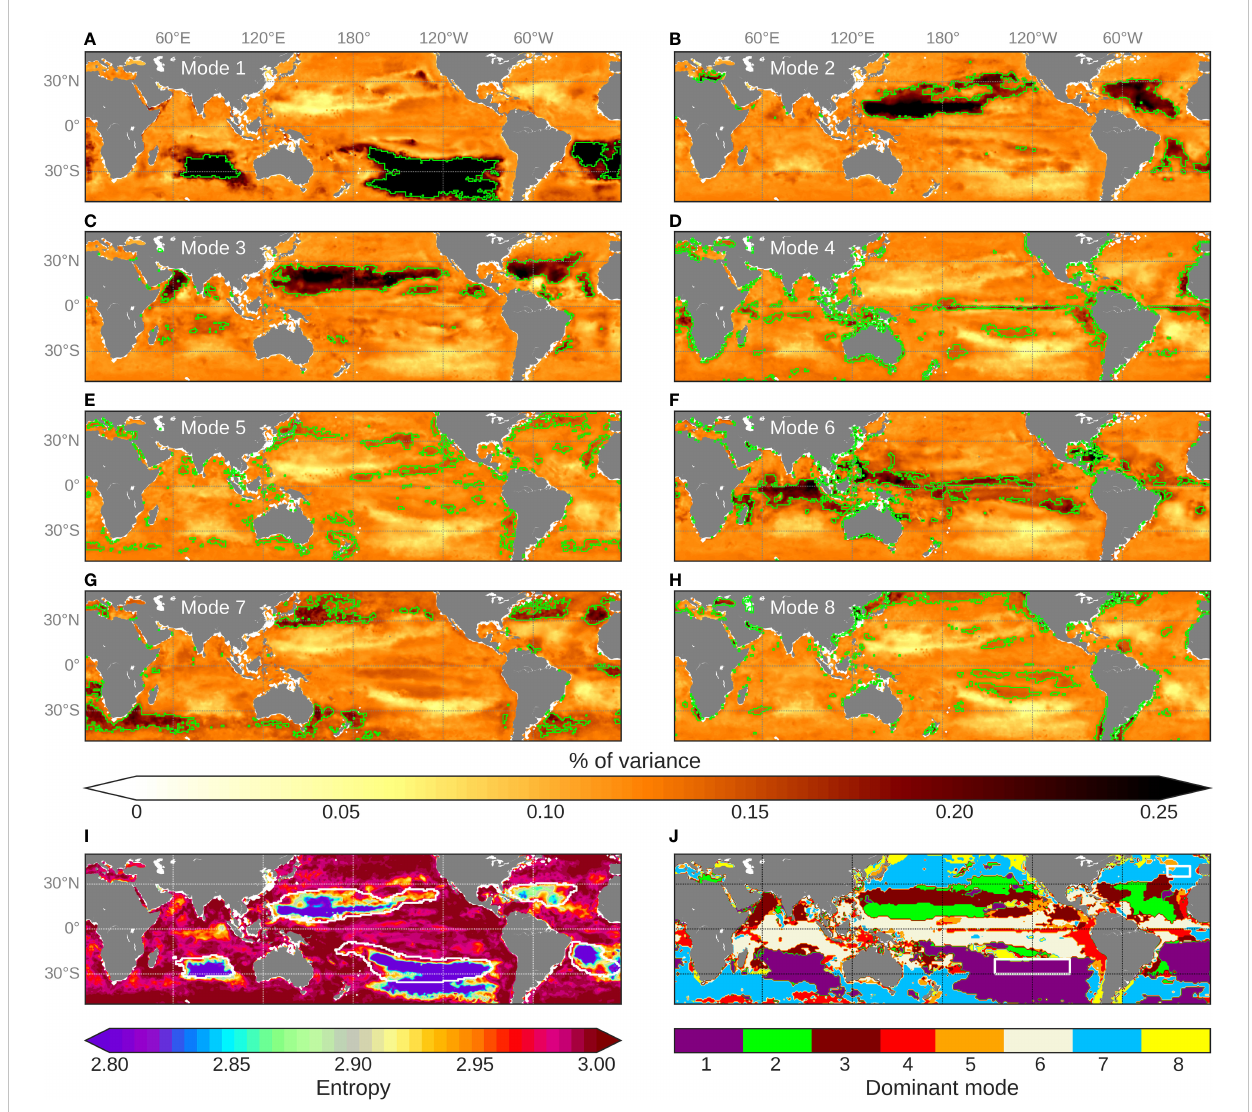
FIGURE 7 (A – H) Percentages of variance explained by each of the 8 modes of CNNMM8. Isolines of percentile-90 of the values are superposed in green. (I) Entropy characteristics computed from the above percentage of variance. Oligotrophic areas (with mean Chl < 0.07 mg.m-3 calculated over [2012-2015]) are delineated as white isocontours. (J) Spatial distribution of the modes explaining the highest percentage of